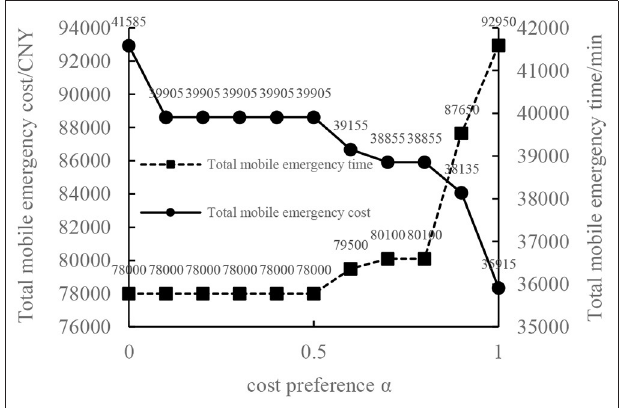
FIGURE 2 | Mobile emergence cost and time variation under different cost preference degrees.